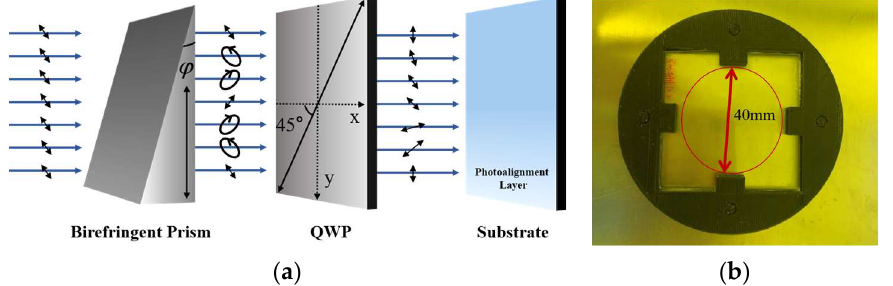
Figure 3. ( a ) Schematics of generation of exposure beam with continuously changing polarization state using birefringent prism and QWP [26]; ( b ) photograph of manufactured broadband LCPG.